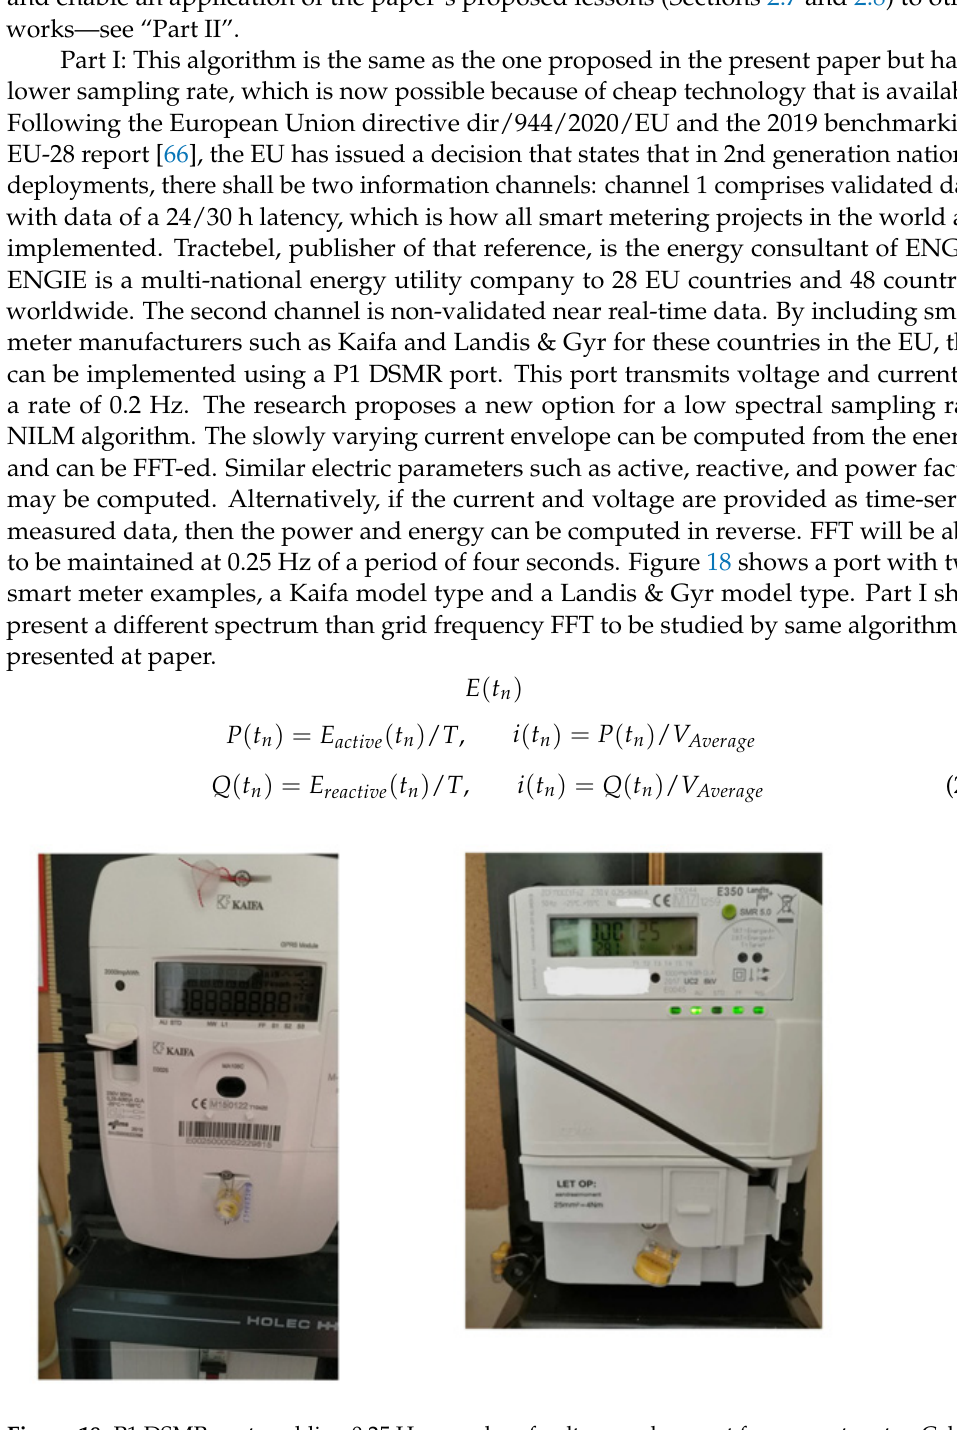
Figure 18. P1 DSMR port enabling 0.25 Hz samples of voltage and current from smart meter. Cables are drawn from the port. The port can be connected to a transmitting modem.